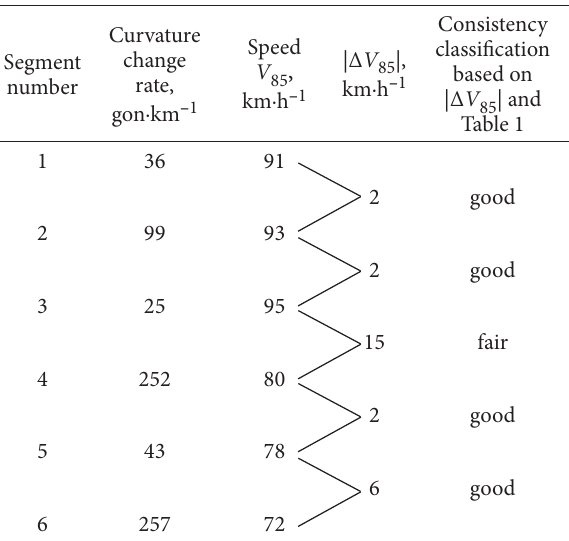
Table 2. Calculated values of curvature change rates and speed in segments